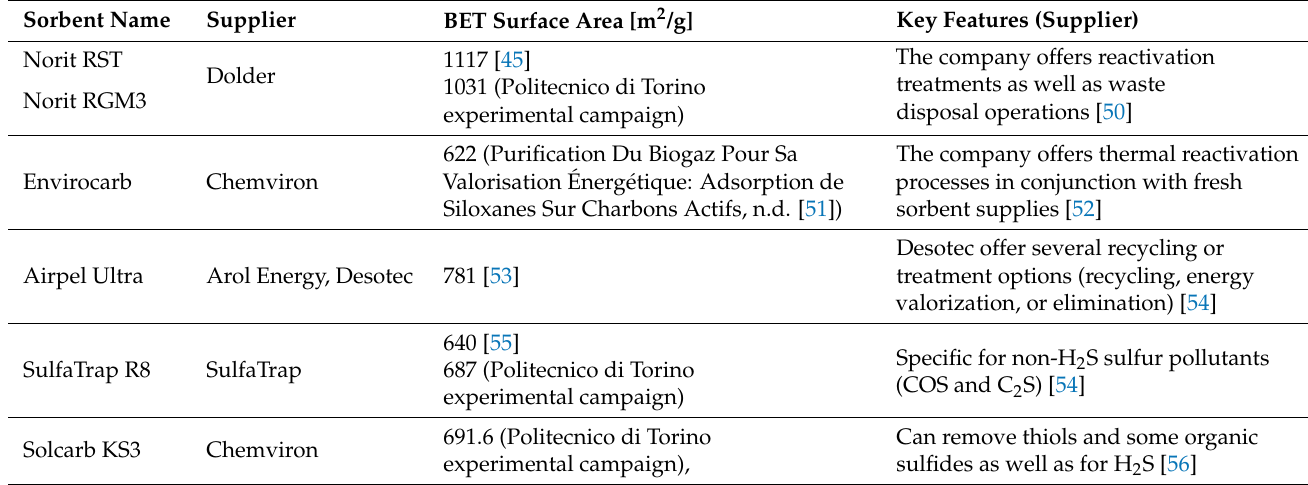
Table 3. List of the main activated carbons suppliers and sorbents